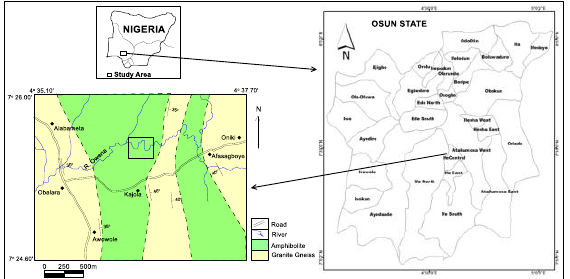
Figure 1: Geologic Map of Kajola and its Environs (Adekoya, 2008; Egwuatu, 2006)